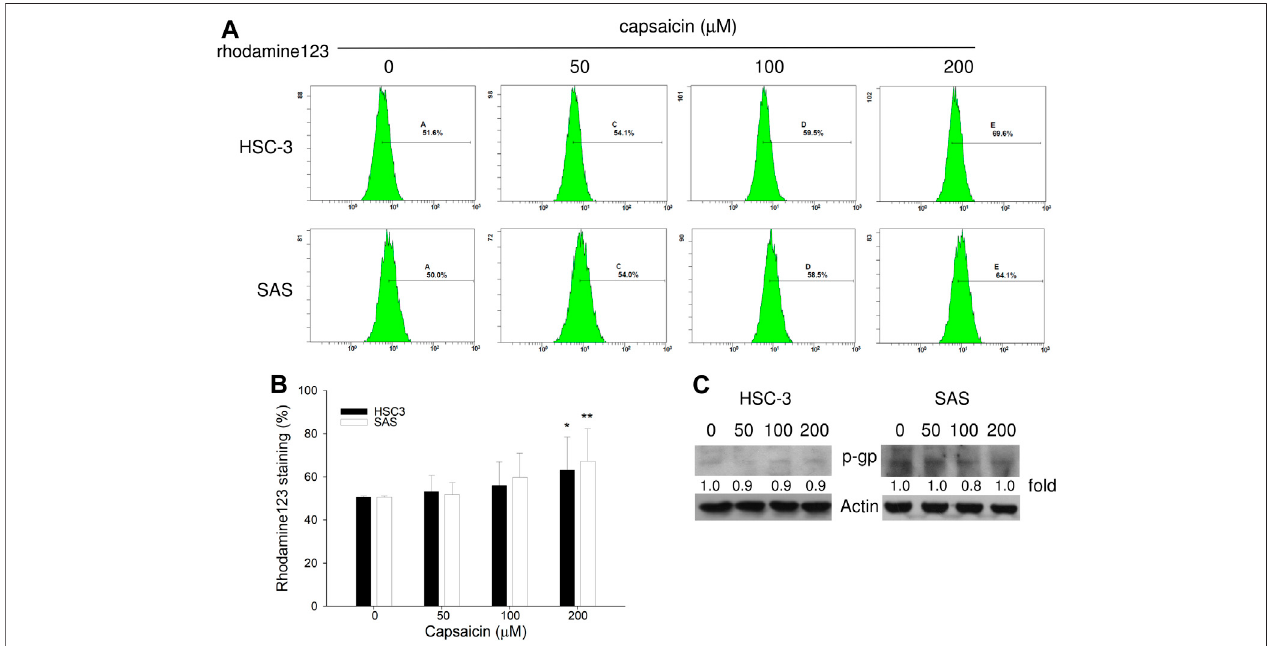
FIGURE 5 | The exclusion of rhodamine 123 is decreased by capsaicin. (A,B) Cells were treated with different concentrations of capsaicin for 48 h, treated with 0.1 μ M rhodamine 123 for 30 min, and analyzed by fl ow cytometry. (C) Cells were treated with different concentrations of capsaicin for 48 h, and Western blot assays were used to examine the levels of P-glycoprotein (p-gp). Data are representative of three independent